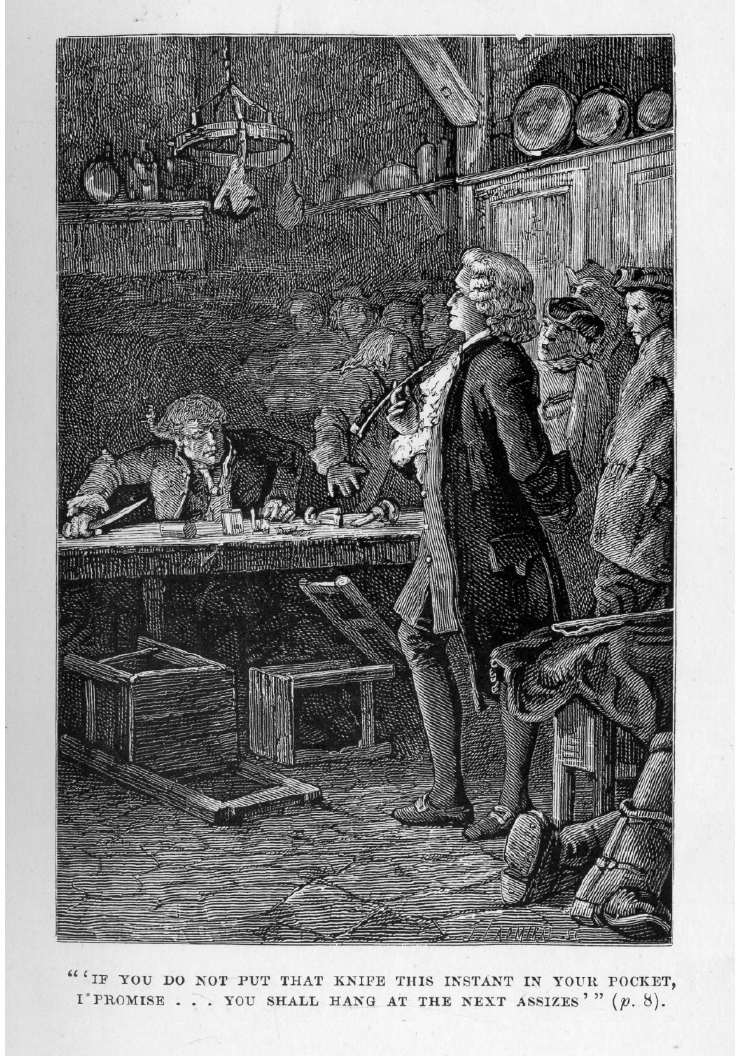
Figure 2. George Roux, “If you do not put that knife this instant in your pocket, I promise … you shall hang at the next assizes” (Roux 1885). From Richard J. Hill’s collection.